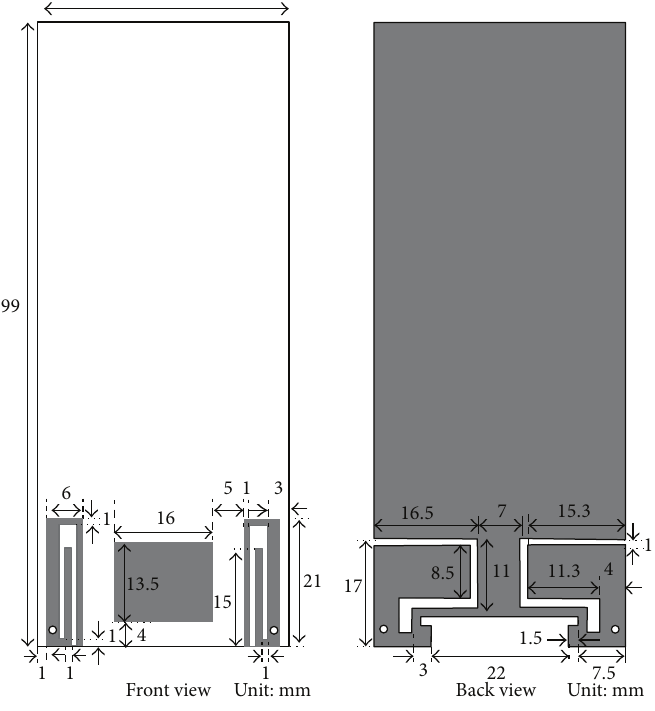
Figure 1: Front and back view of structure and dimension of proposed antenna.